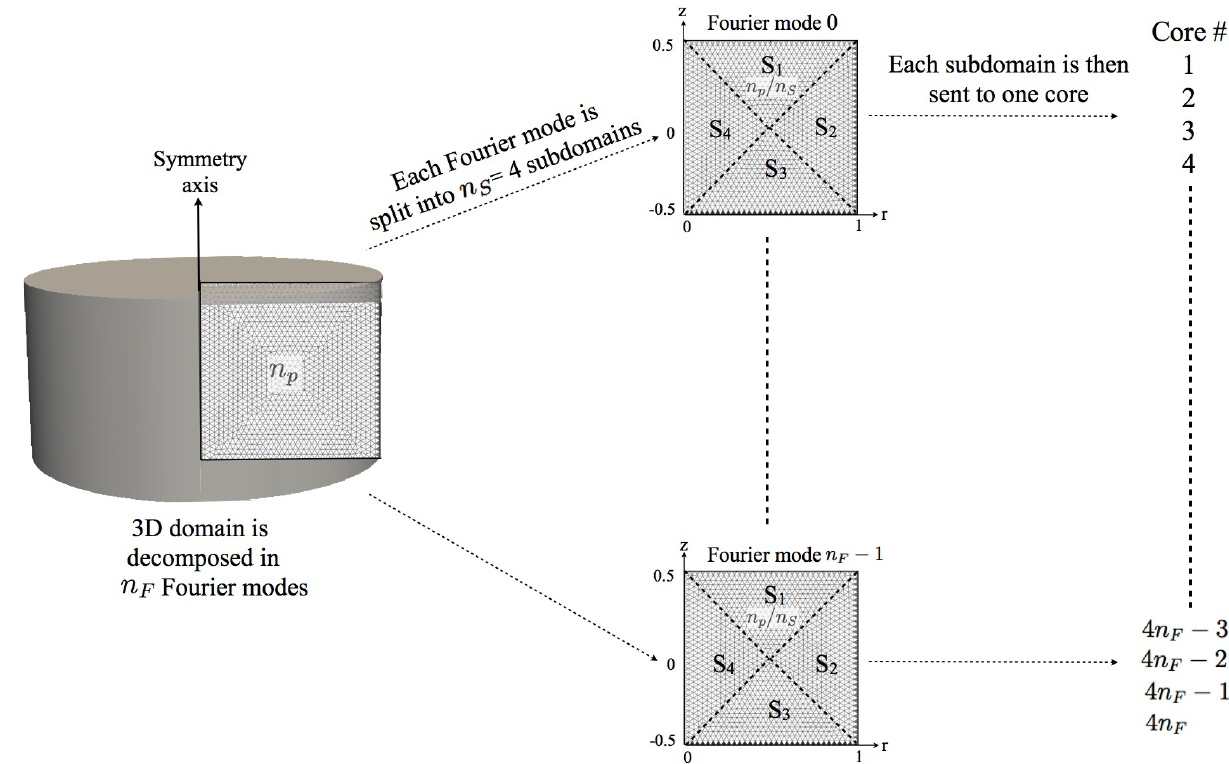
Figure A1. Schematic of the double parallelization used in the SFEMaNS-T code. The solution is represented by a Fourier expansion with n grid mesh is approximated via finite elements, and is decomposed into n total number of cores employed in a given case is n the RBC 4 domain geometry, but for visual clarity only 1/50th of the meridional resolution n is